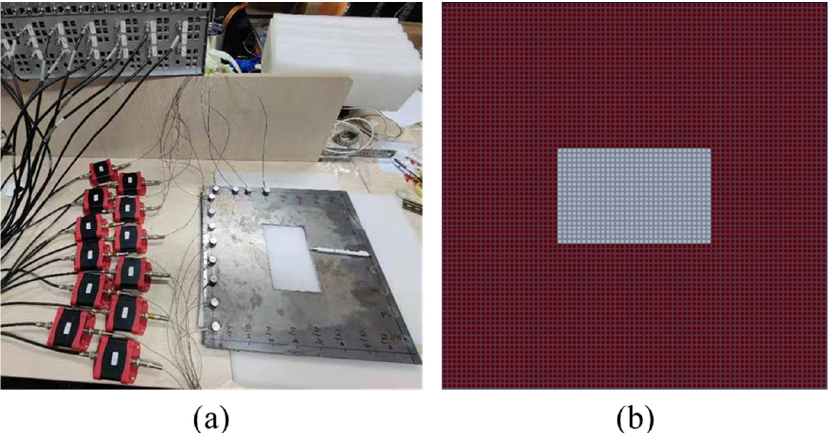
Figure 6. Laboratory AE tomography experiments: ( a ) experimental platform for detecting cavity damage; ( b ) mesh grids for the experiment, white grids represent cavity damage regions and red grids represent the steel plate.